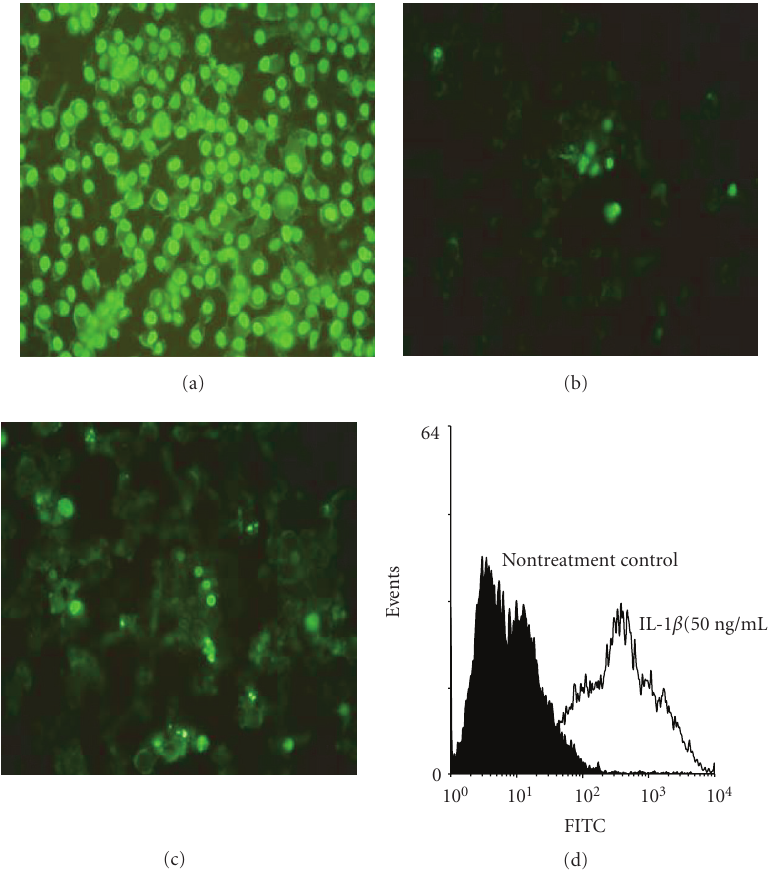
Figure 3: IL-1 induction of apoptosis. JAR cells were cultured in serum-free RPMI 1640 with or without IL-1 and incubated for 72 hours. In situ cell death detection was then performed and apoptosis was visualized by fluorescent microscopy. Apoptotic cells showed a green fluorescent nucleus. (a) Nuclease treated (positive control); (b) untreated control; (c) JAR treated with IL-1 (50ng/mL). Similar experiments were conducted without glass slide and apoptotic cells were determined using flow cytometry